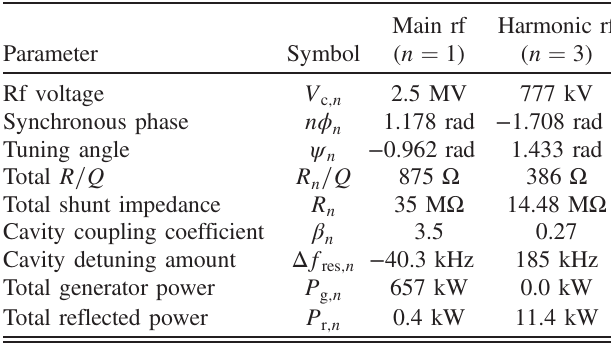
TABLE III. Principal parameters of the double rf system for the KEK-LS at the beam current of 500 mA. For the main and harmonic cavities, the PF-type cavity and the TM020 cavity were assumed,